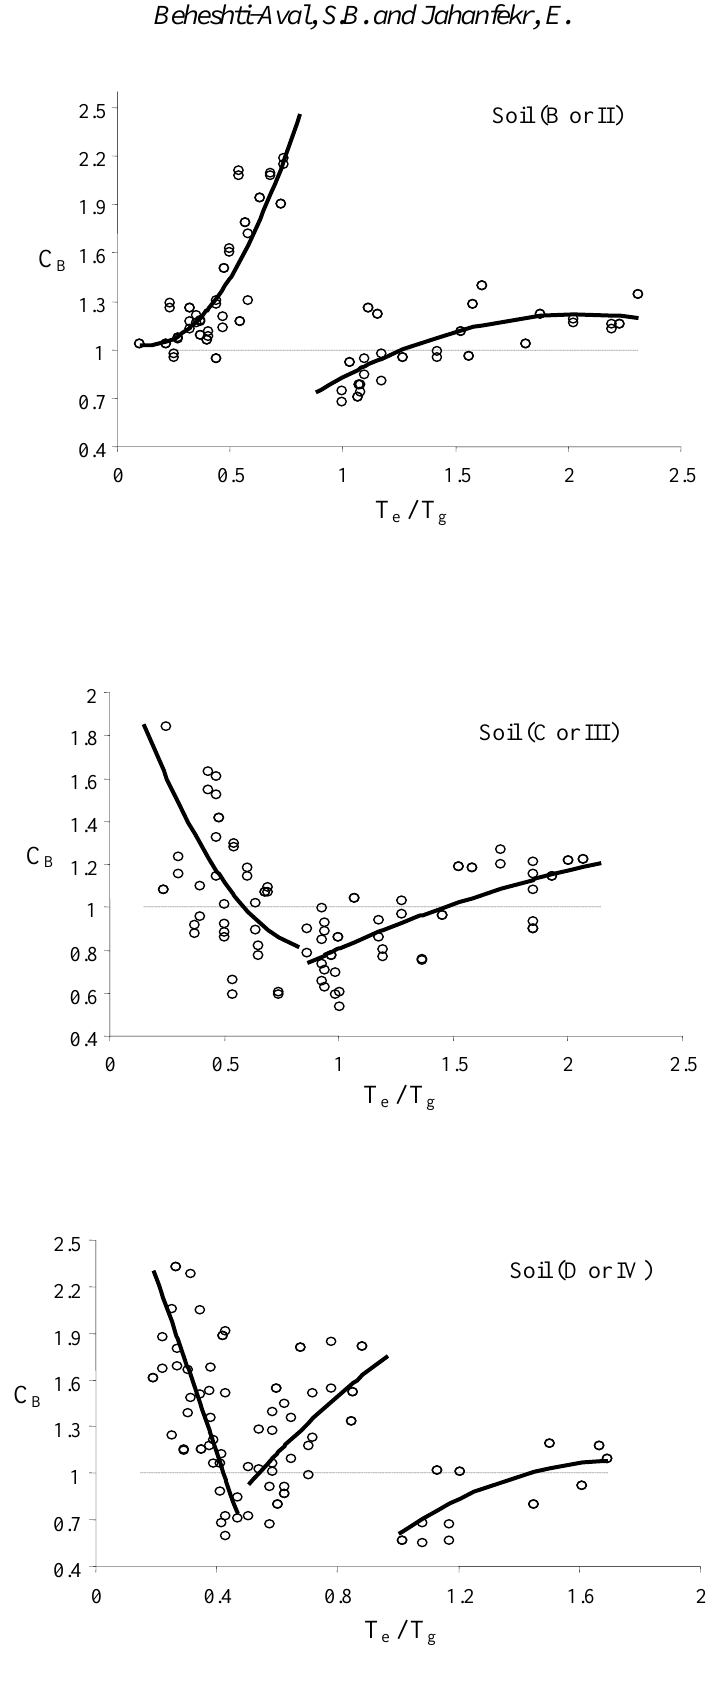
Fig. 17. The coefficient (C